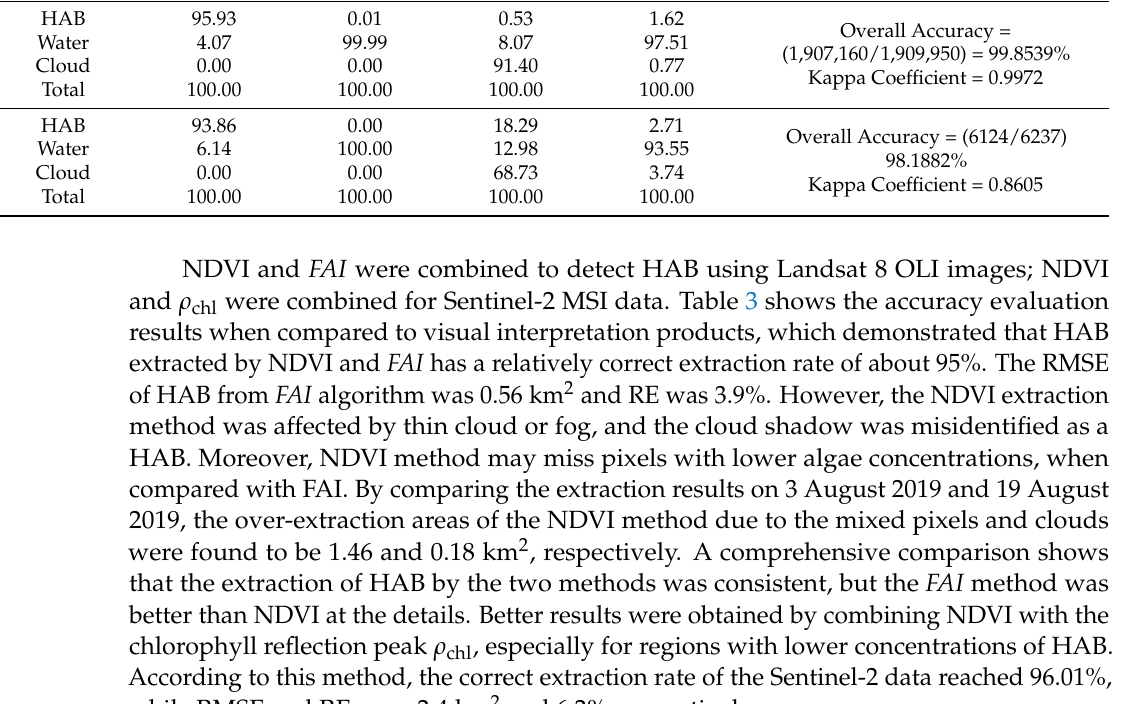
Table 3. Accuracy for HAB extraction of Landsat 8 OLI, Sentnel-2 MSI, and Terra/Aqua MODIS data. Extraction Method